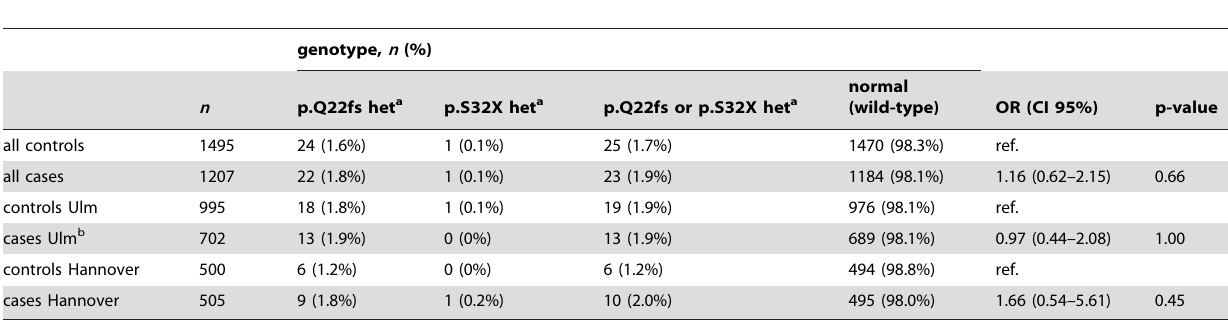
Table 1. Genotype specific odds ratio (OR), exact 95% confidence interval (CI 95%) and p-values of truncating TP53AIP1 variants in case control comparisons.